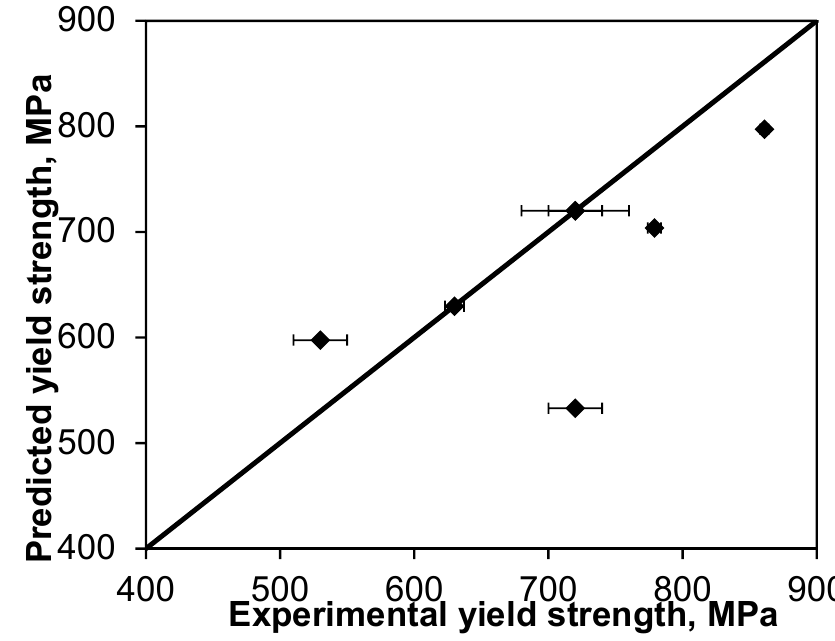
Figure 7. A comparison of the prediction via the present model with the experimental data of Y 2 O 3 -reinforced Ti nanocomposites tested at 20